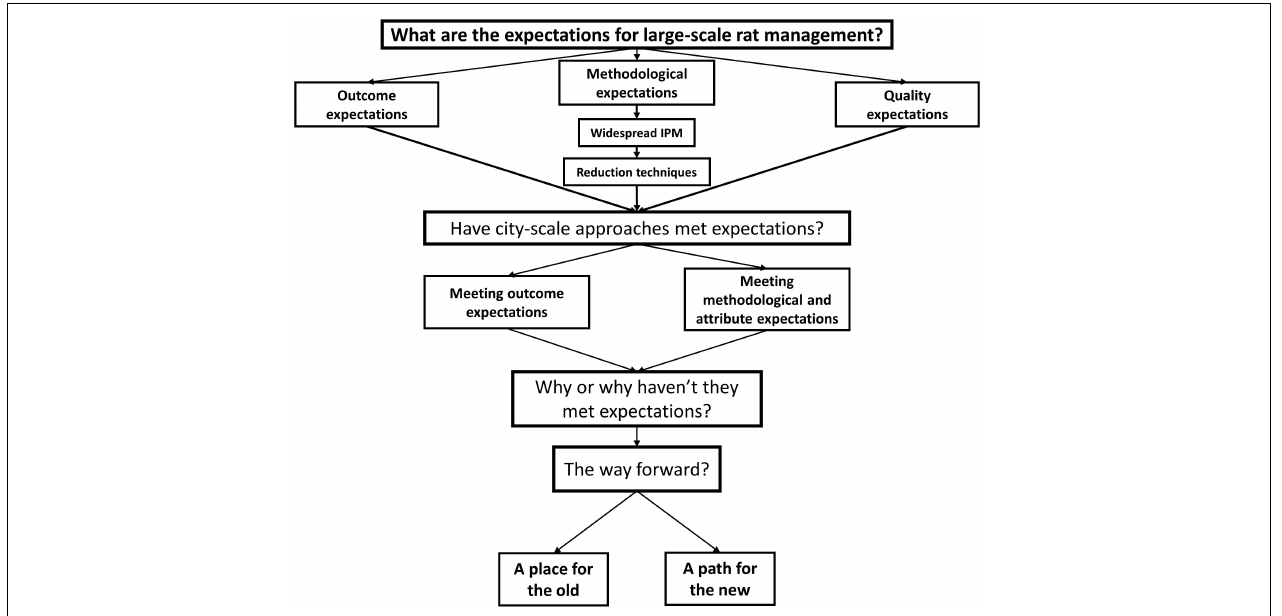
FIGURE 2 | Thematic framework. A priori and emergent themes were organized into subsections within each overarching research question. This framework was used to organize the Results and Discussion section.